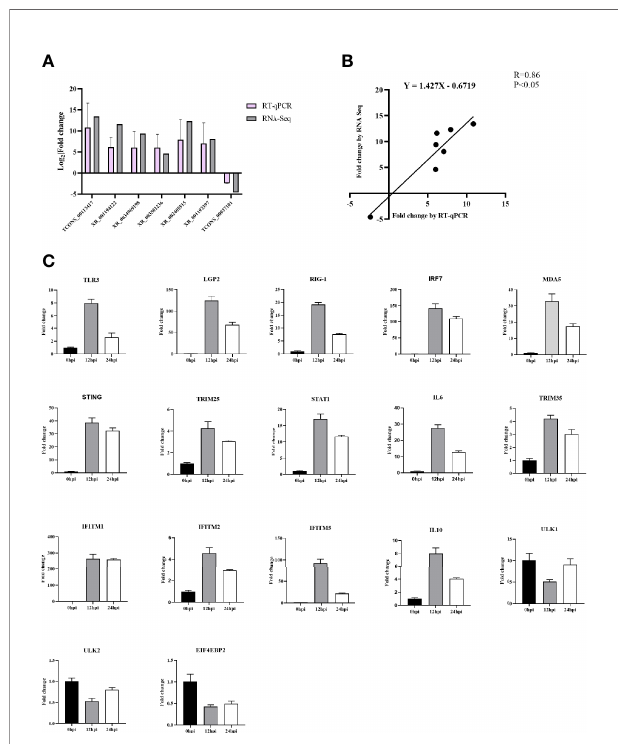
FIGURE 8 | (A) Con fi rmation of DELs by RT-qPCR. (B) The Pearson correlation of expression levels of seven DELs between RT-qPCR and RNA- Seq. (C) Validation of 18 DELs ’ target genes involved in immunity and autophagy signaling pathway after DHAV-1 infection by